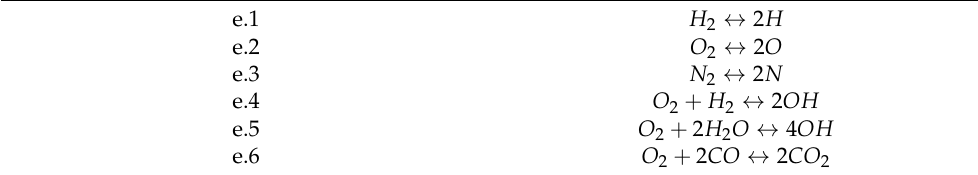
Table 4. Equilibrium reactions.